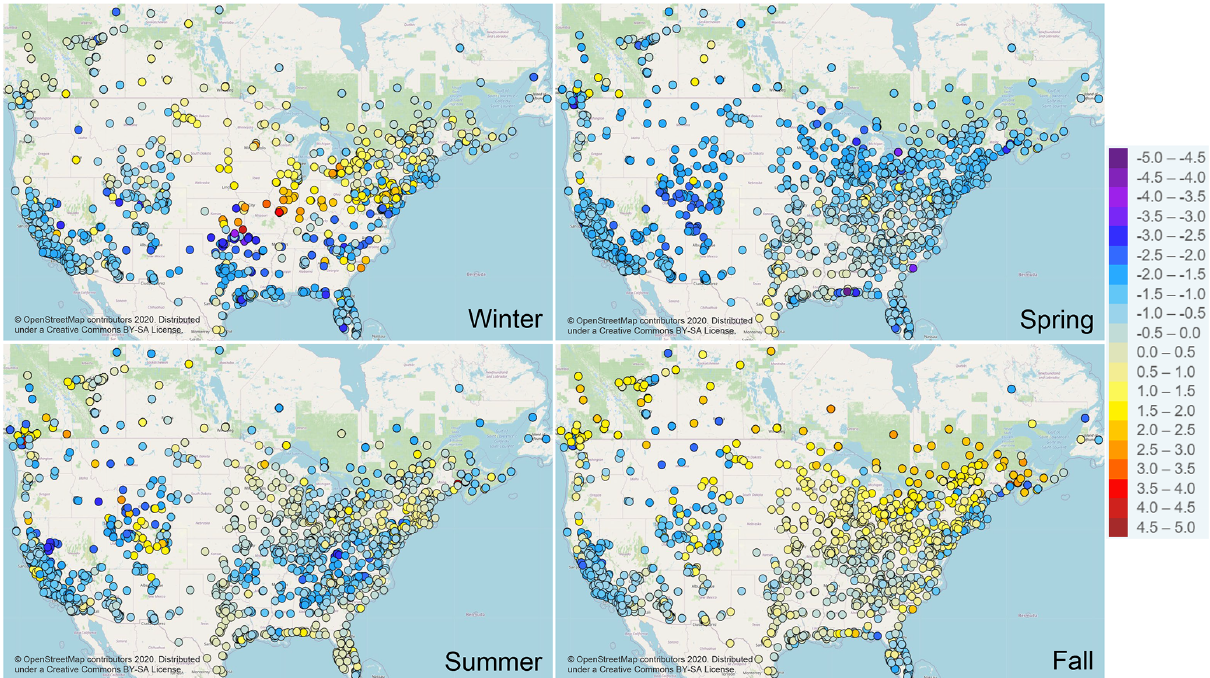
Figure 14. Seasonal average MDA8 O 3 absolute bias difference (ppbv) between CMAQ531_WRF411_M3Dry_BiDi and CMAQ531_WRF411_STAGE_BiDi simulations for all AQS and NAPS sites to highlight the impact of the M3Dry and STAGE deposi- tion models. Cool shading (negative values) indicates smaller bias in the CMAQ531_WRF411_M3Dry_BiDi simulation, and warm colors (positive values) indicate smaller bias in the CMAQ531_WRF411_STAGE_BiDi